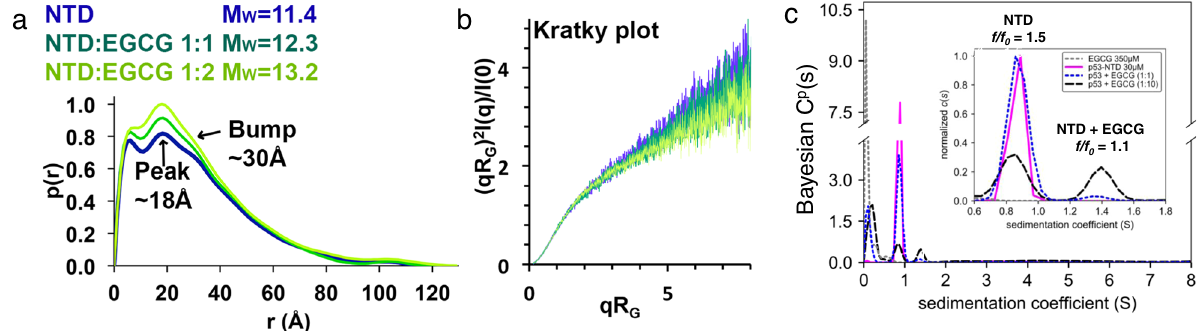
Fig. 3 SAXS and SV-AUC experiments showed that EGCG induces conformational change and the emergence of a compact subpopulation of